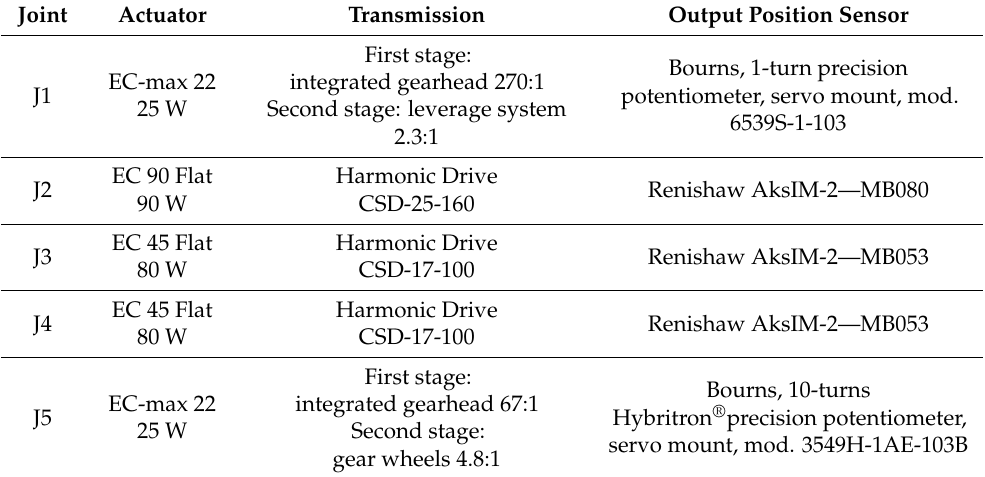
Table 1. List of motors, transmissions and position sensors for the output of each